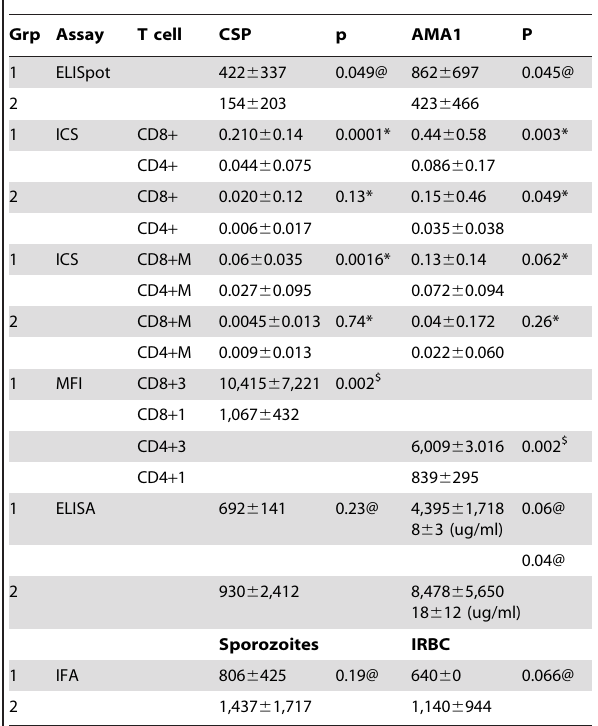
Table 8. Summary of immunogenicity activities.